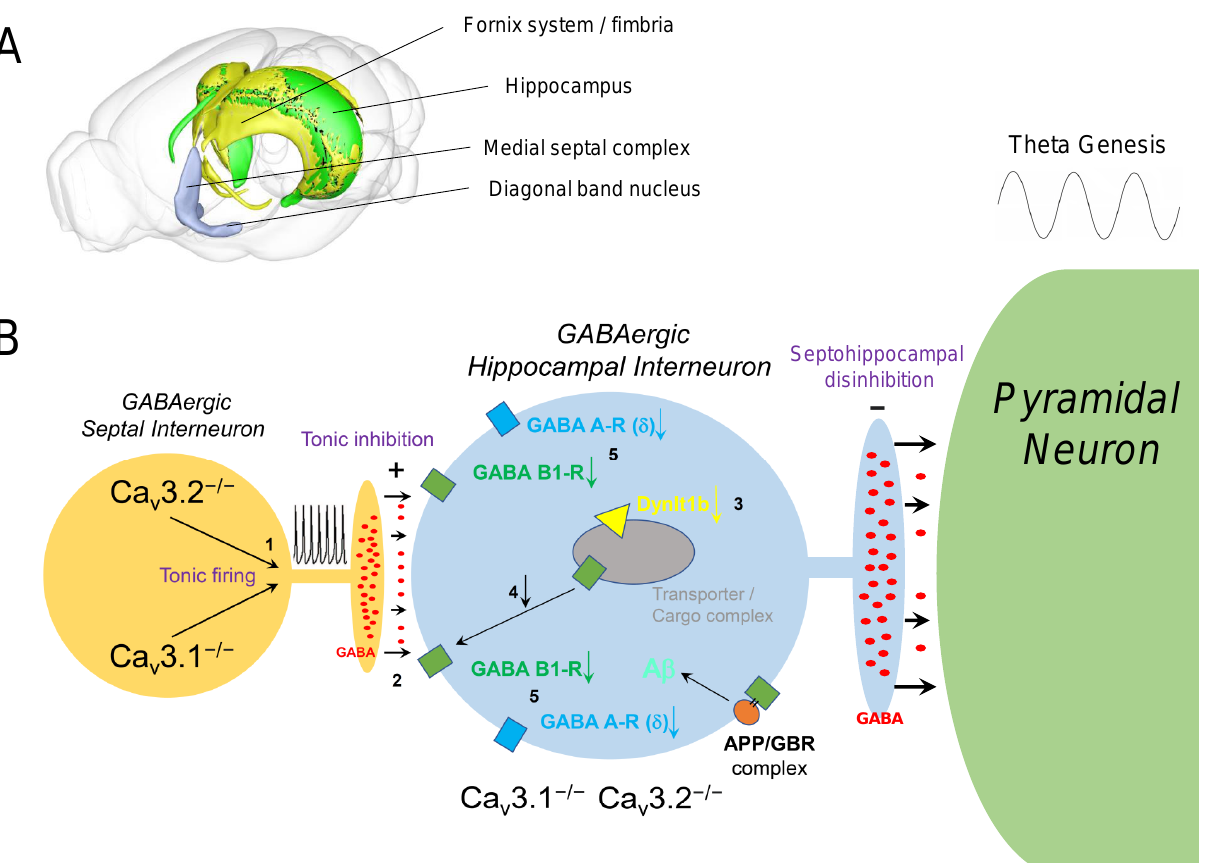
Figure 2. Altered GABAergic physiology in the septohippocampal system upon Ca v 3 VGCC ablation. ( A ) This 3D illustration of the mouse brain including the septohippocampal system/pathway was generated using the “Scalable Brain Atlas” [151]. Blue, medial septal complex, diagonal band of Broca; green, hippocampus; yellow, fornix system/fimbria. ( B ) Increased GABA release from